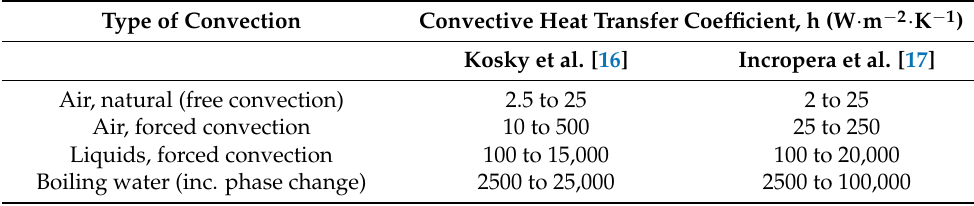
Table 1. Convective heat transfer coefficients, as recommended in literature